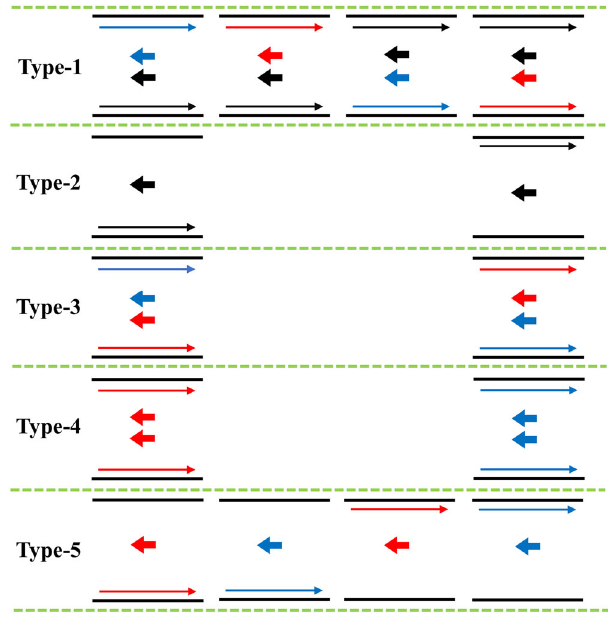
Fig. 3 Schematic diagram of the fi ve possible antichiral edge states. The black arrows denote the spin degeneracy case, and the red (blue) arrows denote the spin-up (down) case. The thin and thick arrows represent the antichiral edge states and the counterpropagating bulk states, respectively.